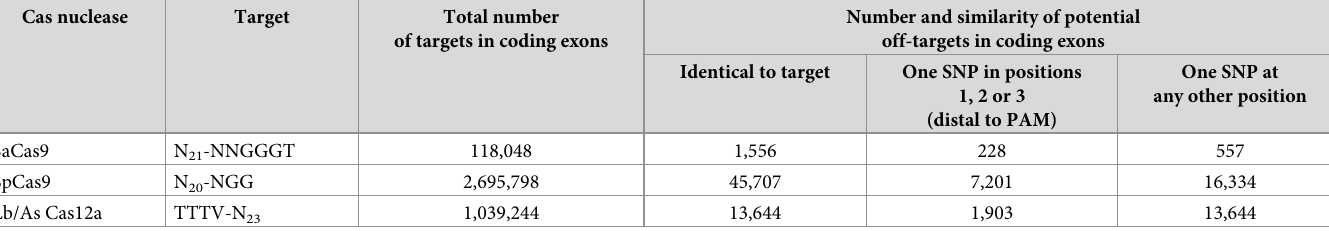
Table 1. Numbers of Cas9 and Cas12 targets and potential off-targets in Arabidopsis coding exons. Cas